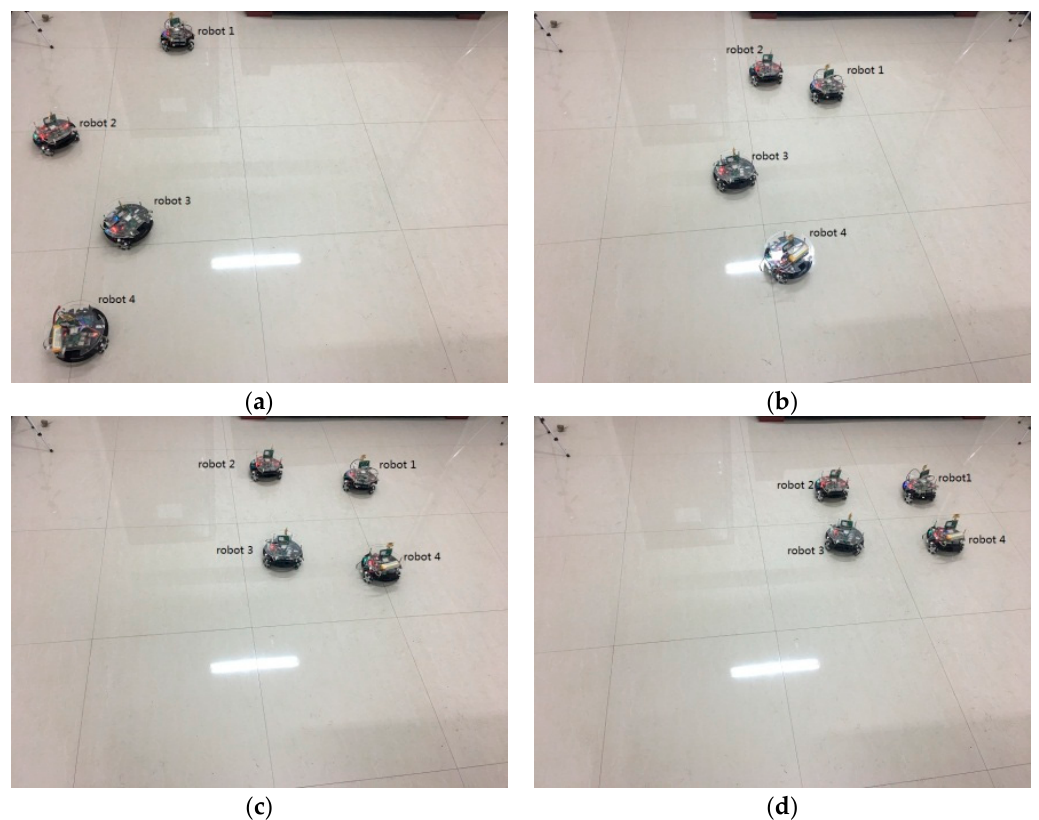
Figure 9. Experiment process screenshots. ( a ) T = 0 s; ( b ) T = 15 s; ( c ) T = 25 s; ( d ) T = 30 s.